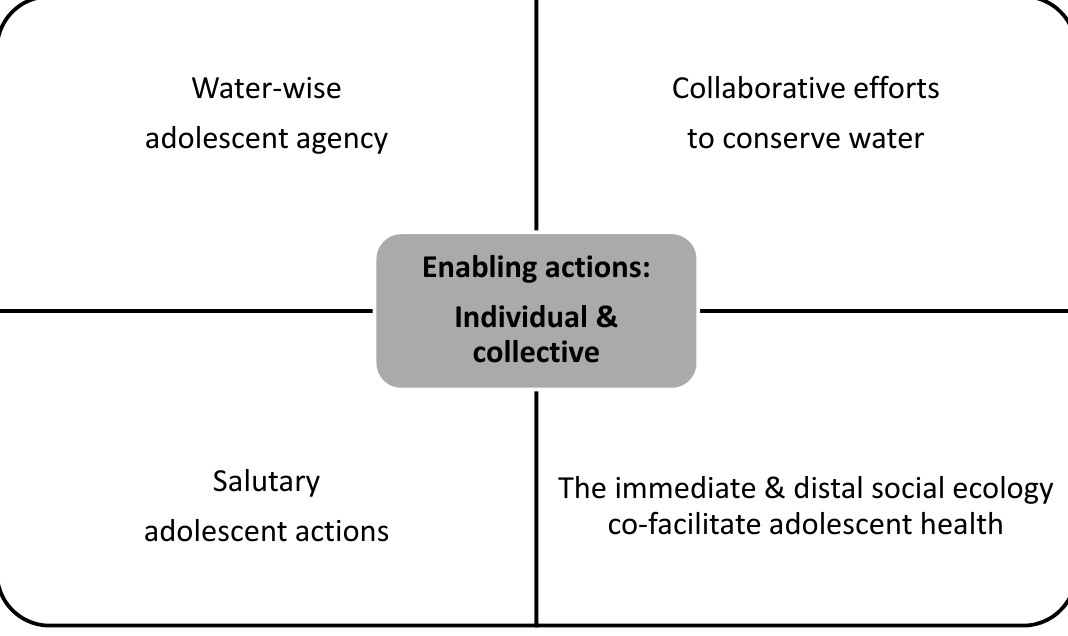
Figure 1. Summary of findings.